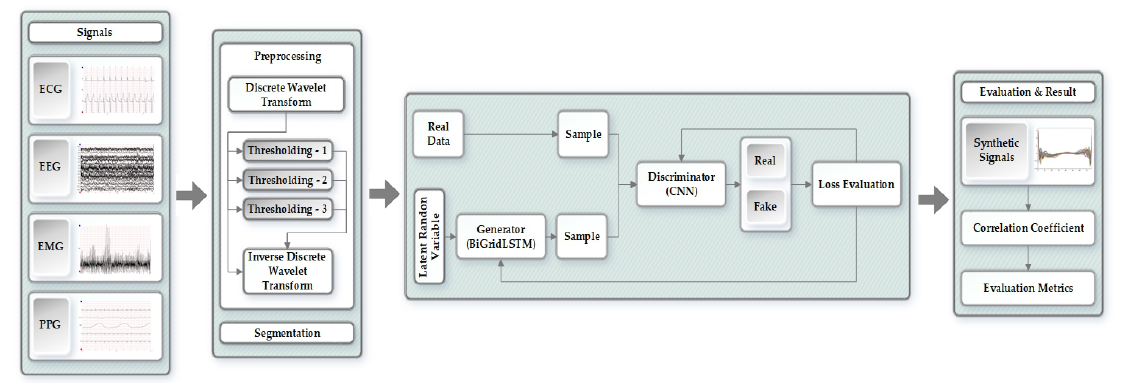
Figure 1. Overview of the proposed approach.